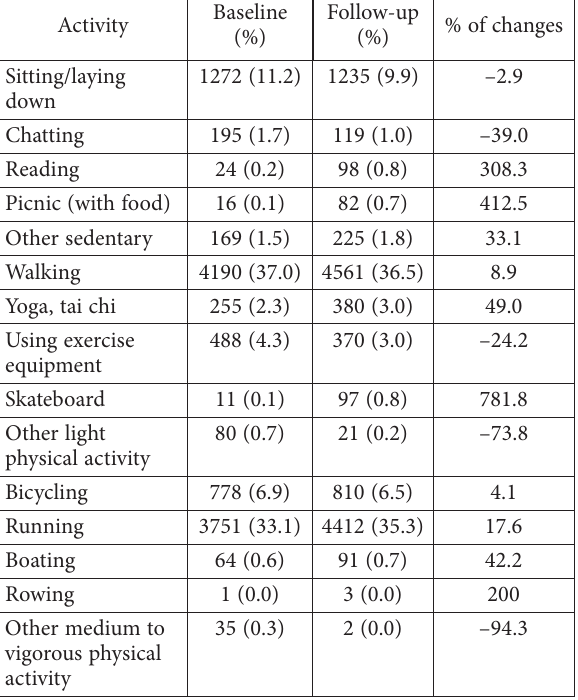
Table 2. Comparison of the total number of users stratified